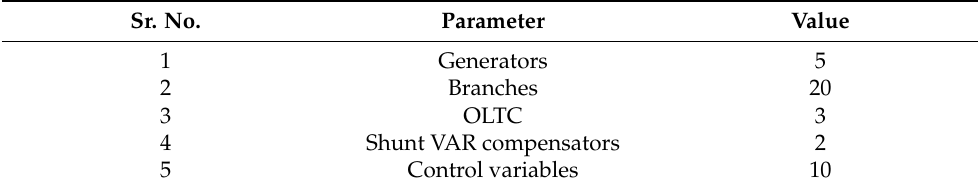
Table 2. Technical parameters of IEEE 14 bus test system. Sr. No.